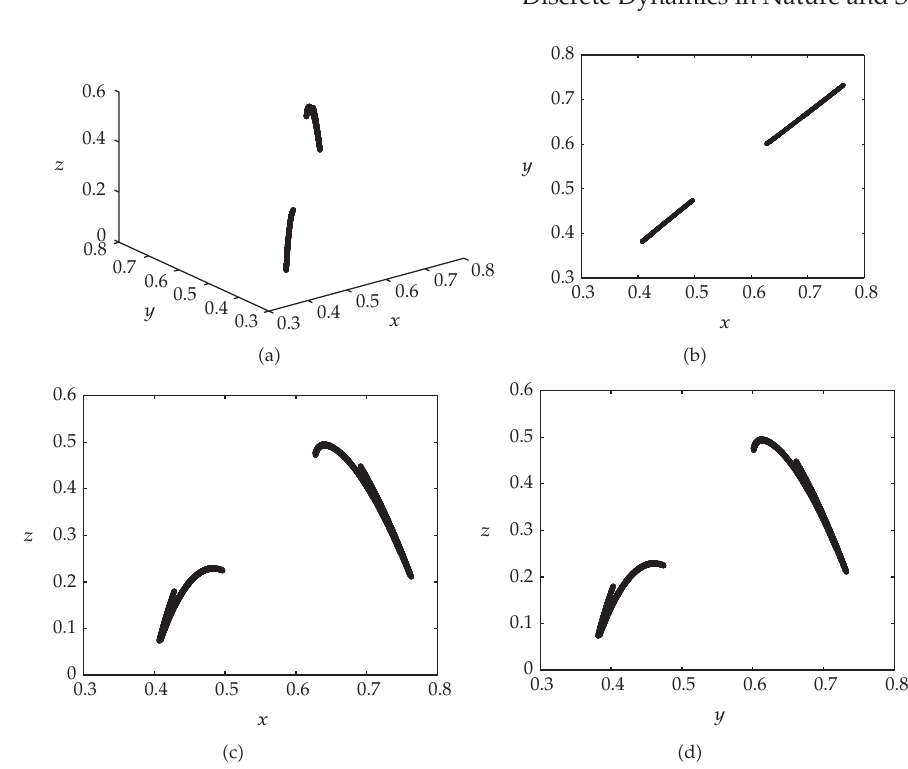
Figure 1: (cid:5) a (cid:6) Three-dimensional view of the chaotic attractor, (cid:5) b (cid:6) x - y phase plane strange attractor, (cid:5) c (cid:6) x - z phase plane strange attractor, (cid:5) d (cid:6) y - z phase plane strange attractor with r (cid:7) 0 . 4, α (cid:7) 0 . 63.